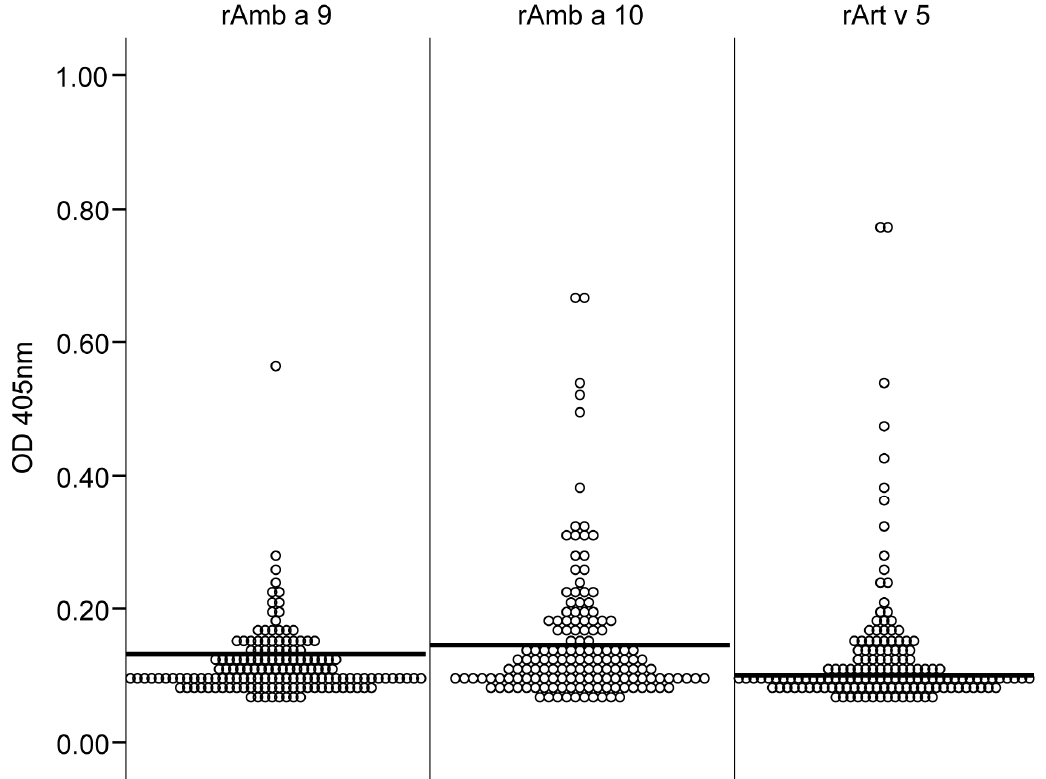
Figure 4. IgE reactivity to calcium-binding proteins rAmb a 9, rAmb a 10 and rArt v 5 was determined in ELISA assays using sera from ragweed-allergic patients ( n = 150). The optical density values (OD 405 nm) displayed on the y-axis correspond to the levels of IgE antibodies. The cut-off value is indicated for Amb a 9 (0.1317), Amb a 10 (0.1453) and Art v 5 (0.100) allergens (horizontal line).